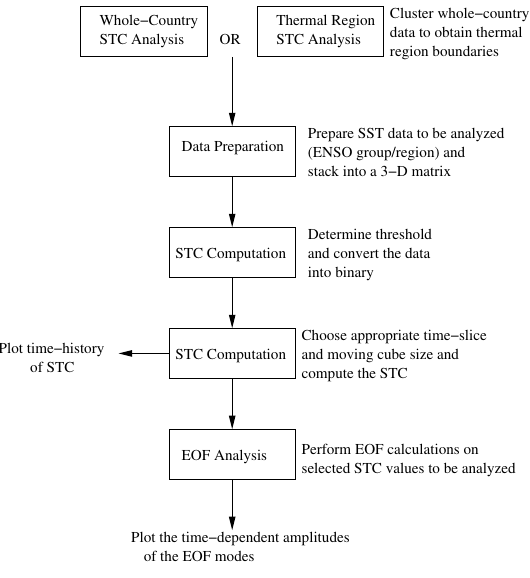
Fig. 3. A flowchart of the steps in the analysis of SST data.